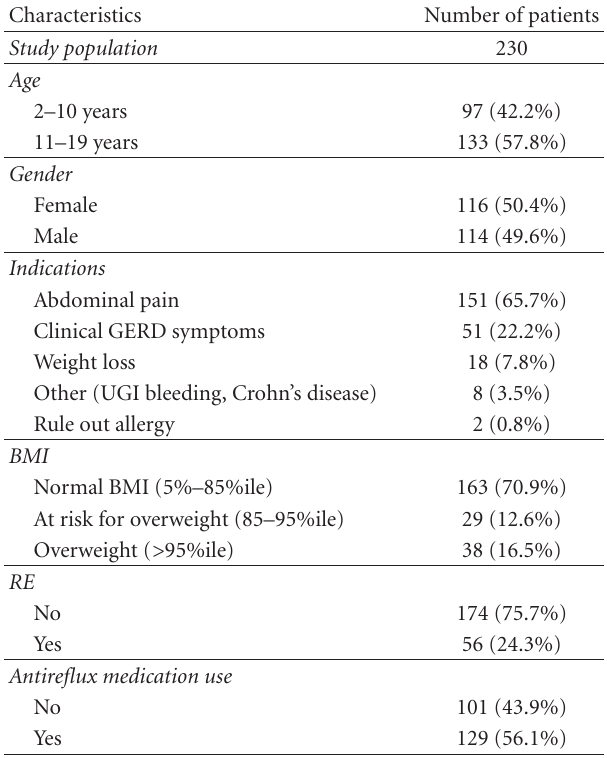
Table 1: Characteristics of study population.